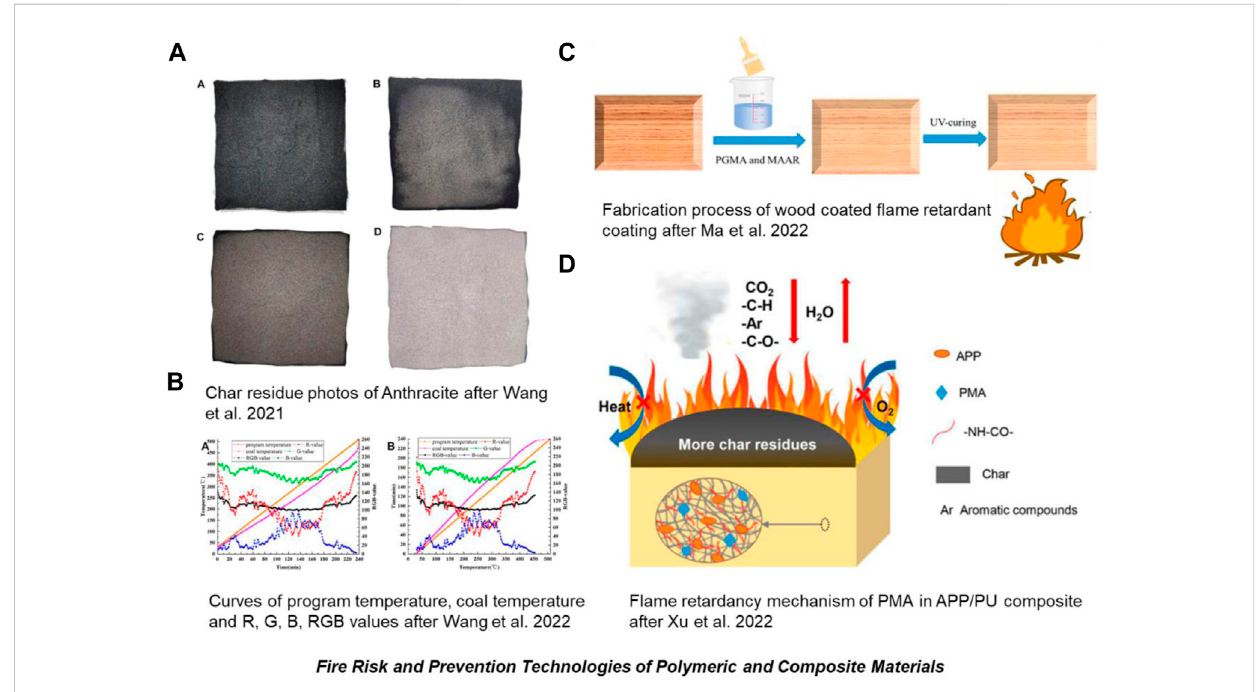
Advancement of fi re risk and prevention technologies of polymeric and composite materials. Images in (A) , (B) , (C) and (D) are adapted from Wang et al.; Wang et al.; Ma et al.; Xu et al. respectively, published under the terms of Creative Commons Attribution 4.0 (CC BY